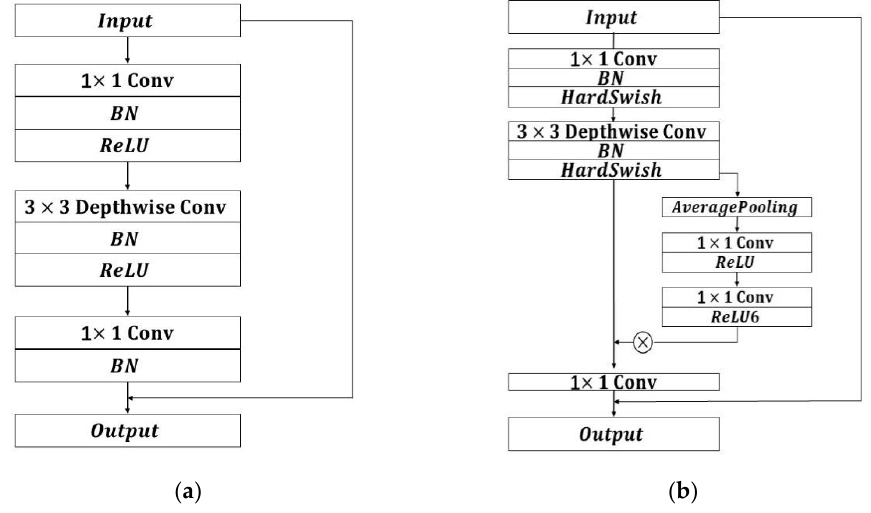
Figure 7. The basic modules that make up ( a ) MobileNetv2 and ( b ) MobileNetv3.